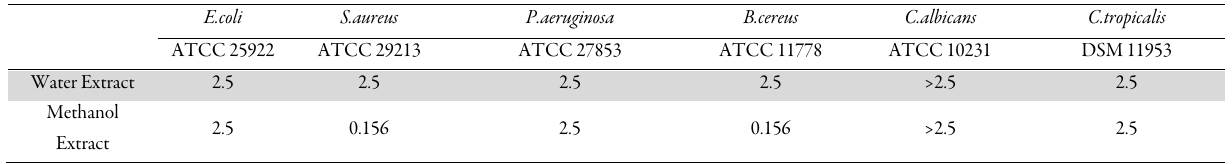
Table 3. Antimicrobial activity results of S. libanotica extracts